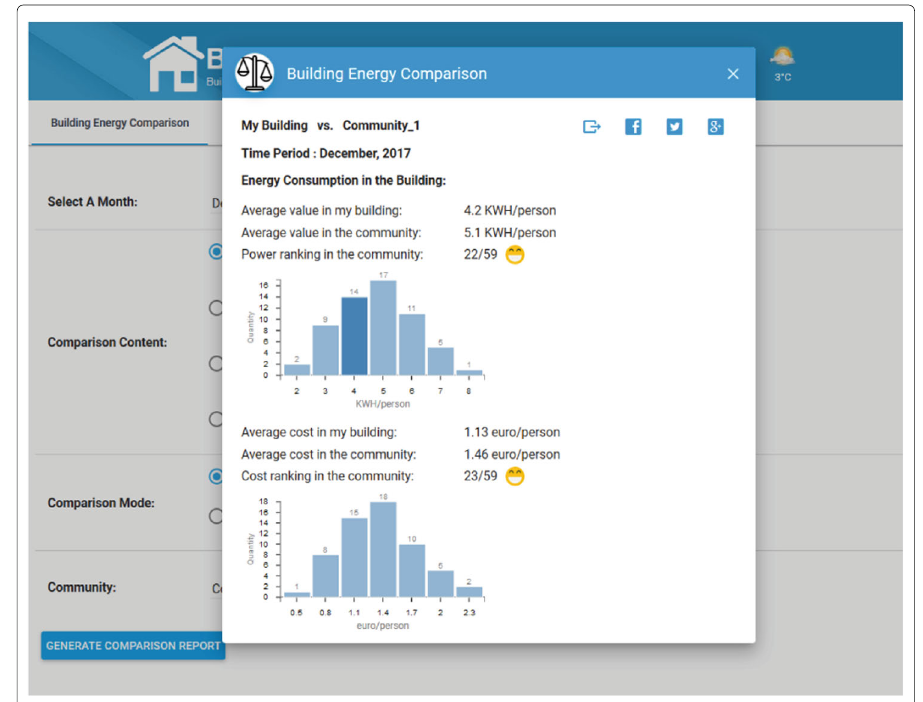
Fig. 13 BOS UI: building energy comparison in a